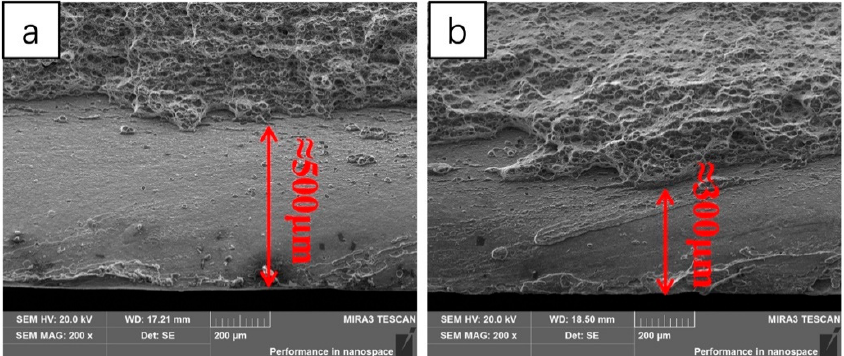
Figure 6. The shape of the bottom of the tensile fracture of the welded joint: ( a ) FSW; ( b ) UAFSW.